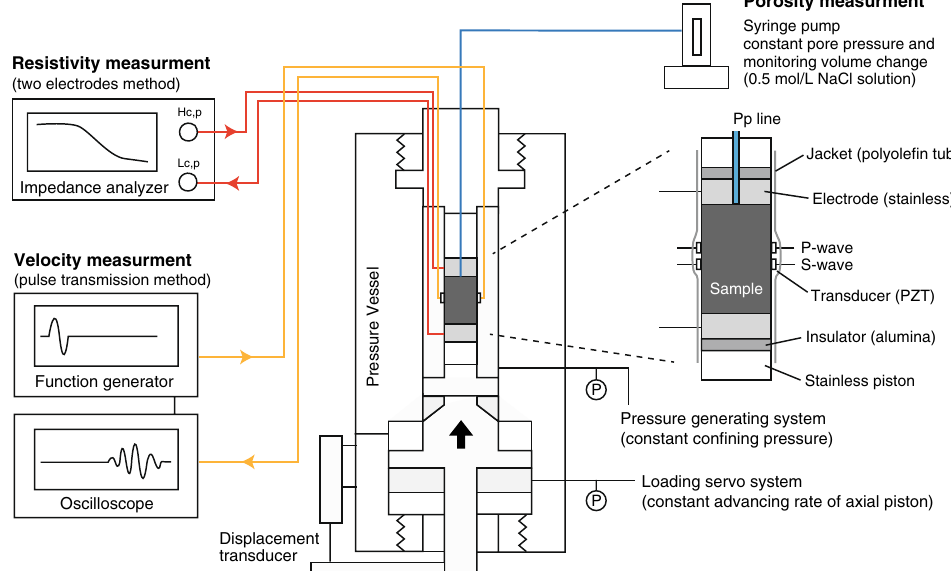
Fig. 1 Schematic diagram showing the experimental apparatus and simultaneous measurement system for electrical resistivity, elastic wave velocity, and porosity. Sample is sandwiched by two electrodes, which are electrically isolated by the alumina insulator, and piezoelectric transducers are directly attached to the